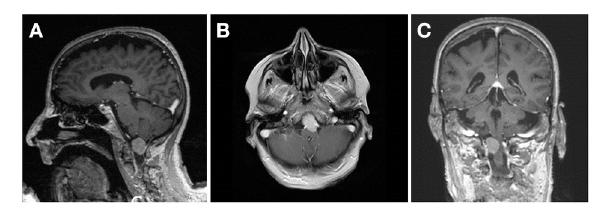
craniocervical meningioma growing anterior and posterior from the denticulate